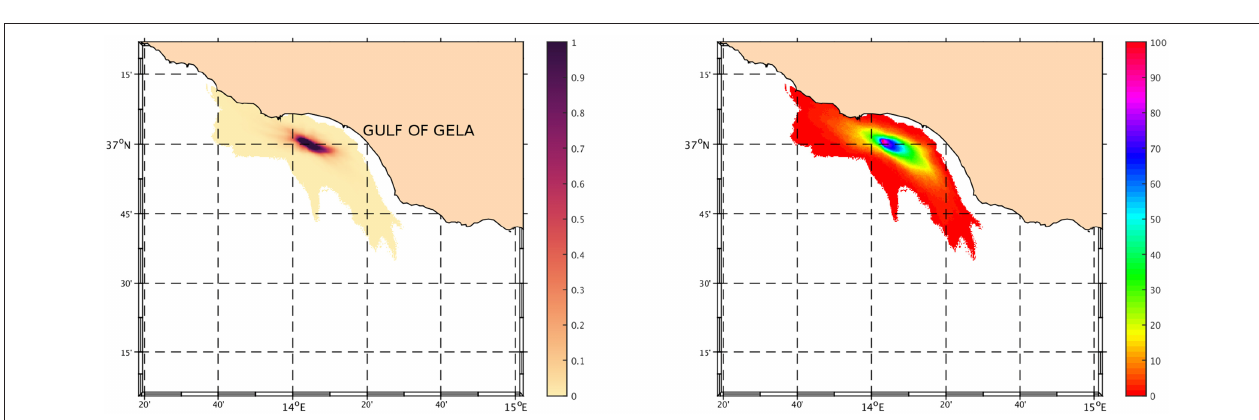
FIGURE 2 | Sarago Mare platform, Adriatic Sea. (Left) 48 h Hazard Index, HI; (Right) 48 h Occurrence Index, OI.